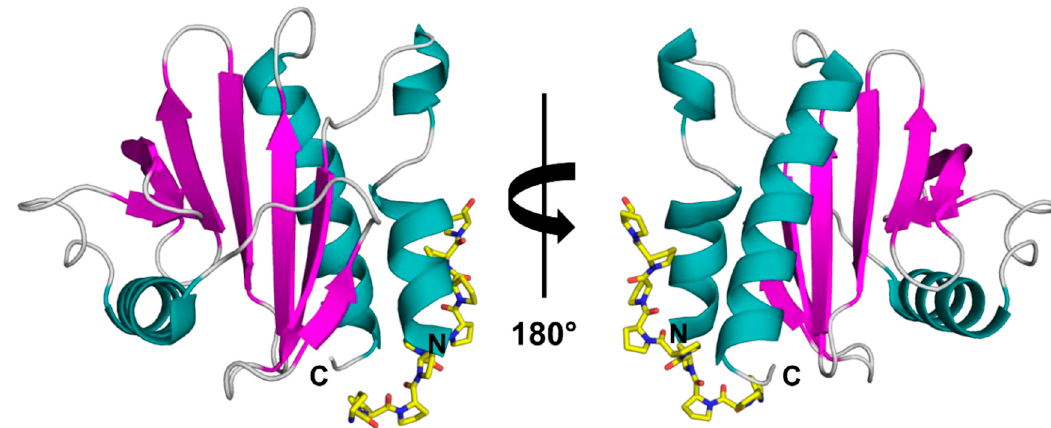
Figure 1. Crystal structure of rArt v 4.0101 (PDB code: 5EM0) with modelled poly(L-Pro). The structure is shown in two different orientations with secondary structure elements colored ( α -helices—teal, β -strands—purple, loops—grey). The poly(L-Pro) is shown in yellow stick representation.